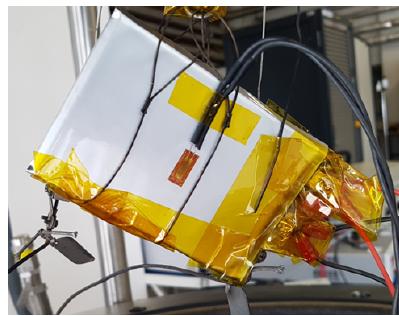
Figure 3. Strain gauge sensor applied to pouch